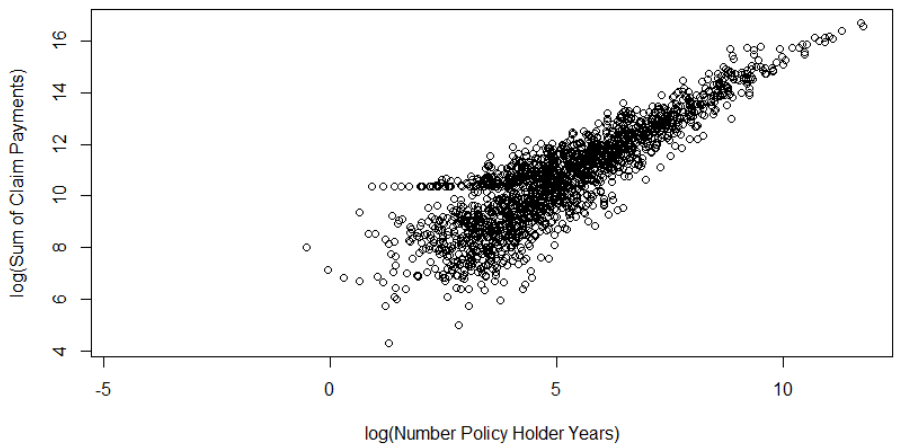
Figure 10. Scatterplot of the Swedish motor data (on a natural log scale).